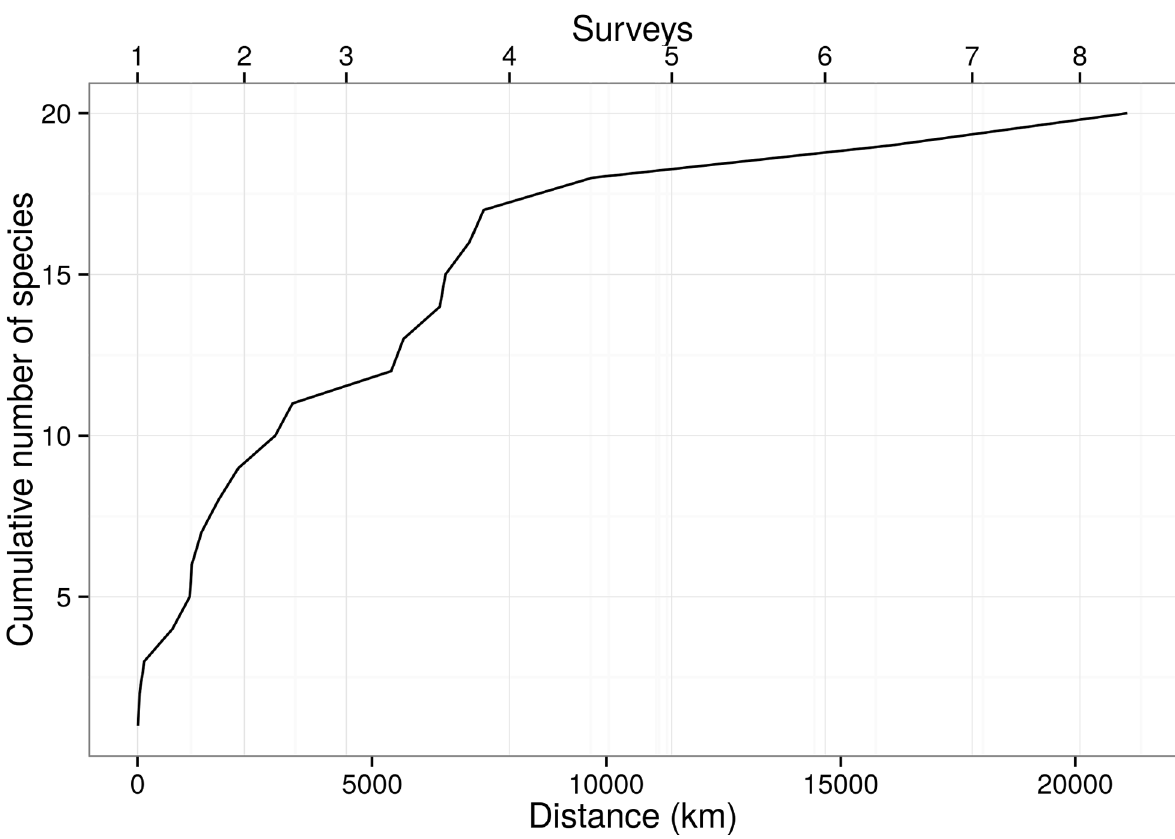
Fig 2. Discovery curve of species identified during the present study. Cumulative number of species recorded according to distance travelled (lower x-axis) and the surveys (upper x-axis).